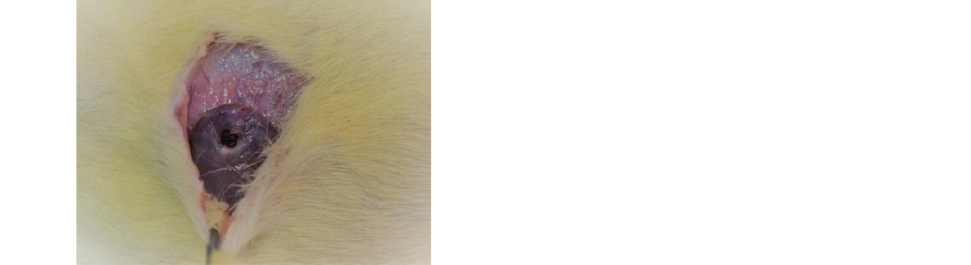
Figure 2. Silicon implant treated with rifampicin – moment of extraction of the implant and a remaining capsule thinner.